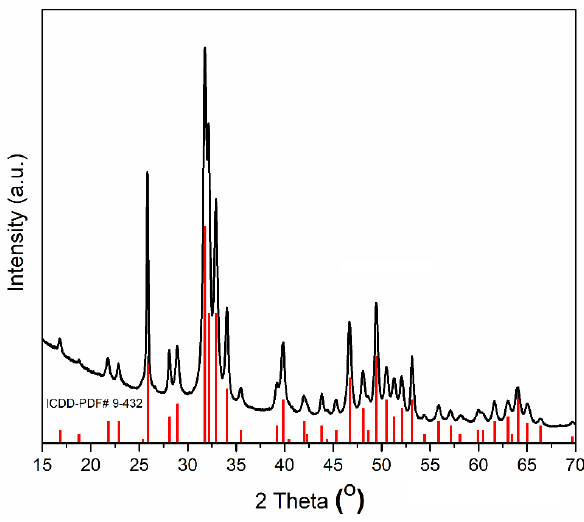
Figure 1. The X-ray diffraction (XRD) patterns of HAp (ICDD-PDF No. 9-432) and obtained HAp powders after centrifugation and drying at 100 ◦ C in an oven.